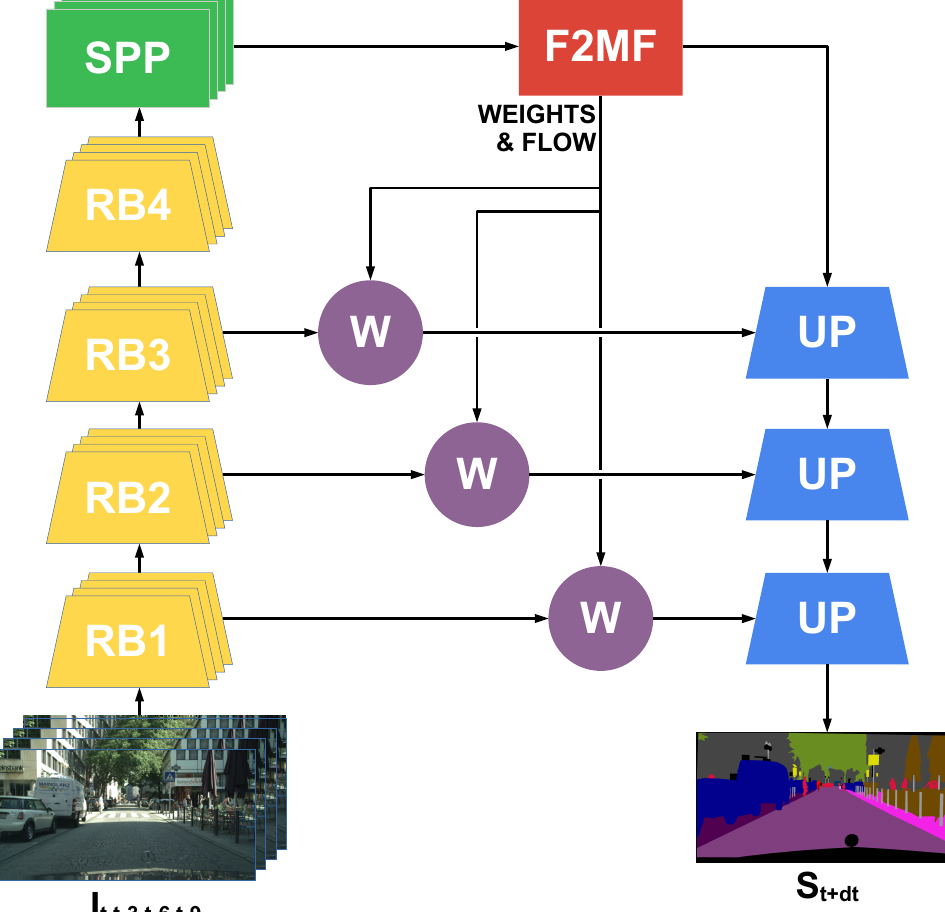
Figure 3. Dense semantic forecasting based on F2F regression and multi-level F2M